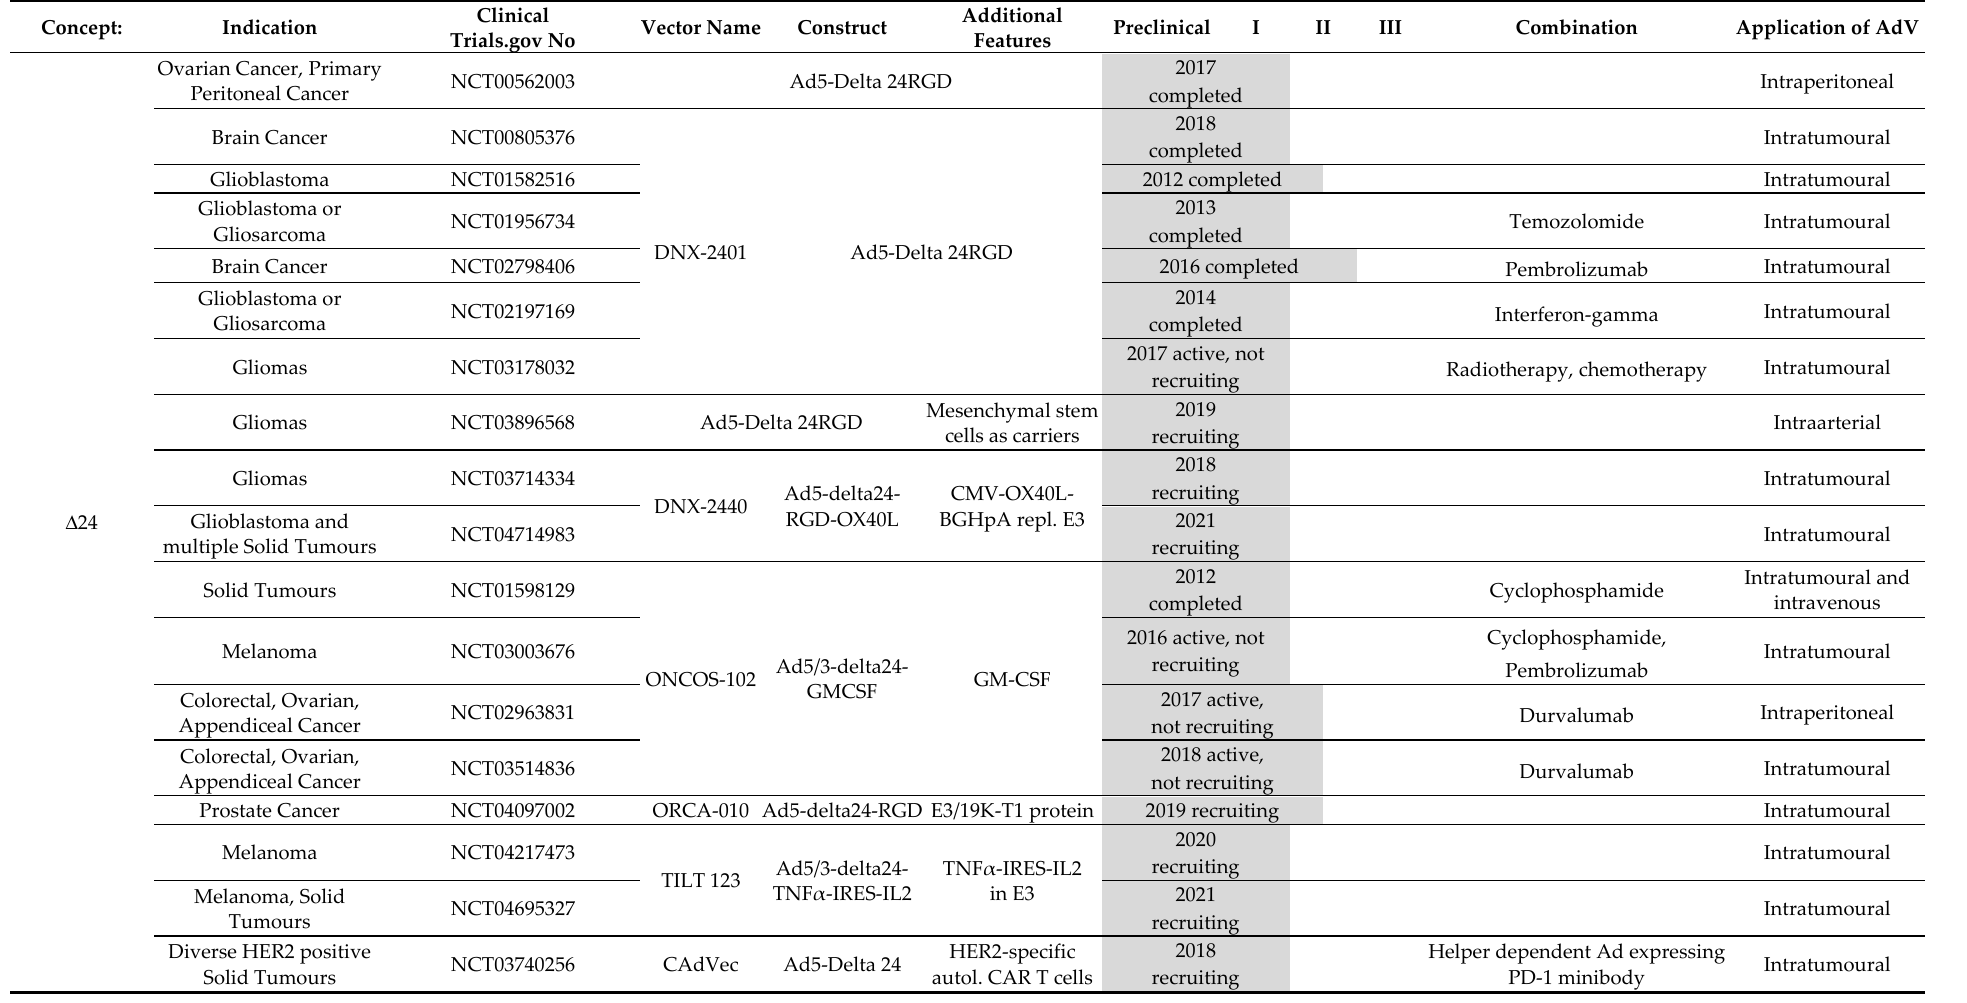
Table 3. Clinical trials using oncolytic adenoviruses with a 24 base pair deletion in E1A.